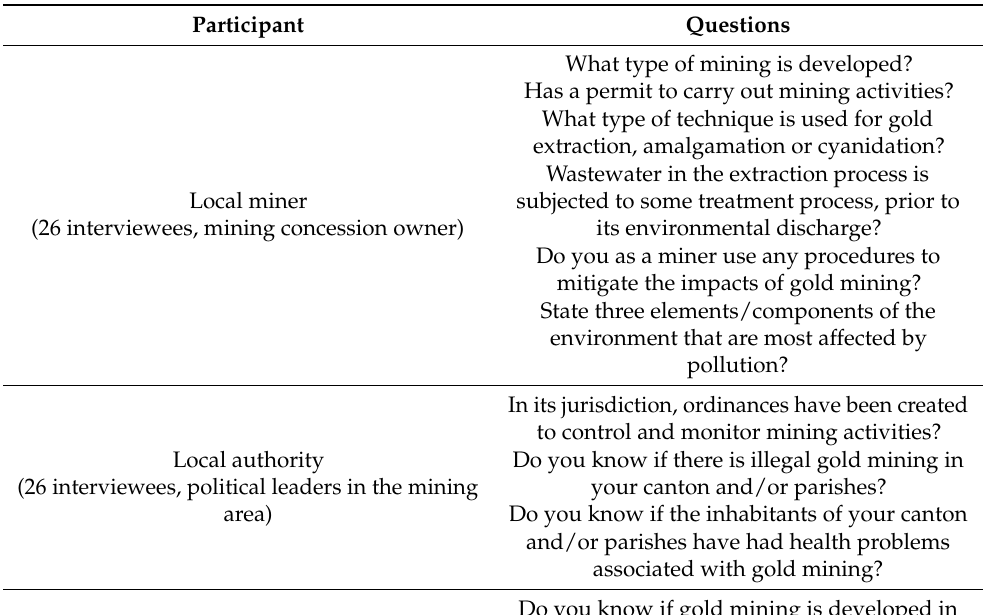
(Table 4). The issues addressed in the interviews were: displacement of people, loss of livelihoods, changes in population dynamics, cost of living, water scarcity and health impacts. Table 4. Questions established to analyze the current situation of gold